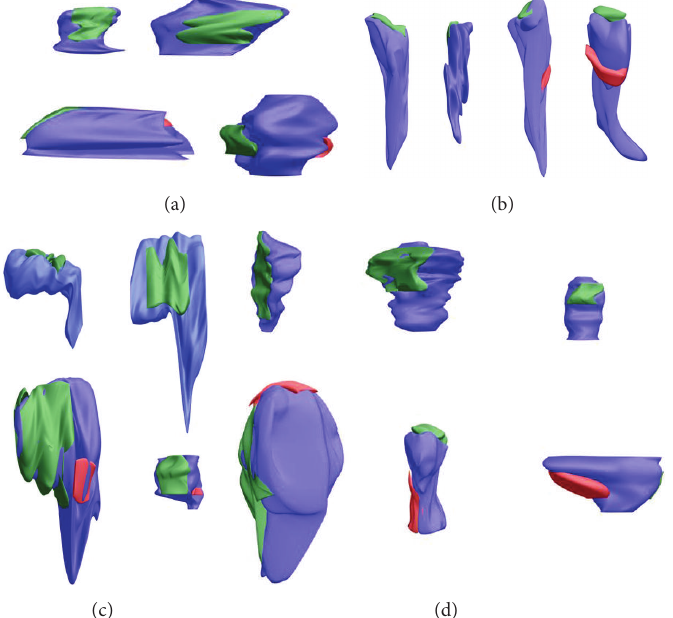
Figure 7: 3D reconstruction of single- and double-synapse spines from serial micrographs showing different shapes of spines: stubby (a), thin (b), mushroom (c), and intermediate (d). Color areas as in Figure 1.